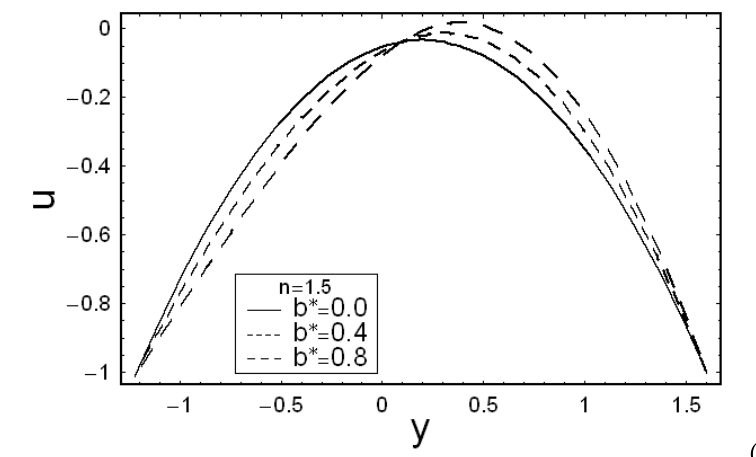
Figure 8. ( a ) Plot of u for b ∗ with a = 0.6, b = 0.3, d = 1.0, φ = π /4, Θ = 1, x = 0 and n = 0.5; ( b ) Plot of u for b ∗ with a = 0.6, b = 0.3, d = 1.0, φ = π /4, Θ = 1, x = 0 and n = 1.5.